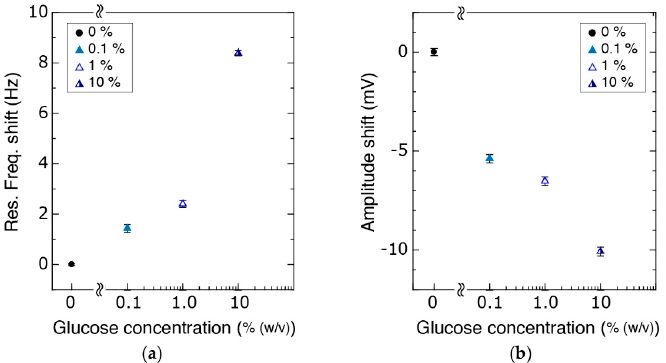
Figure 9. ( a ) Resonance frequency of the system increased with increasing glucose concentration while ( b ) the amplitude decreased. ( b ) the amplitude